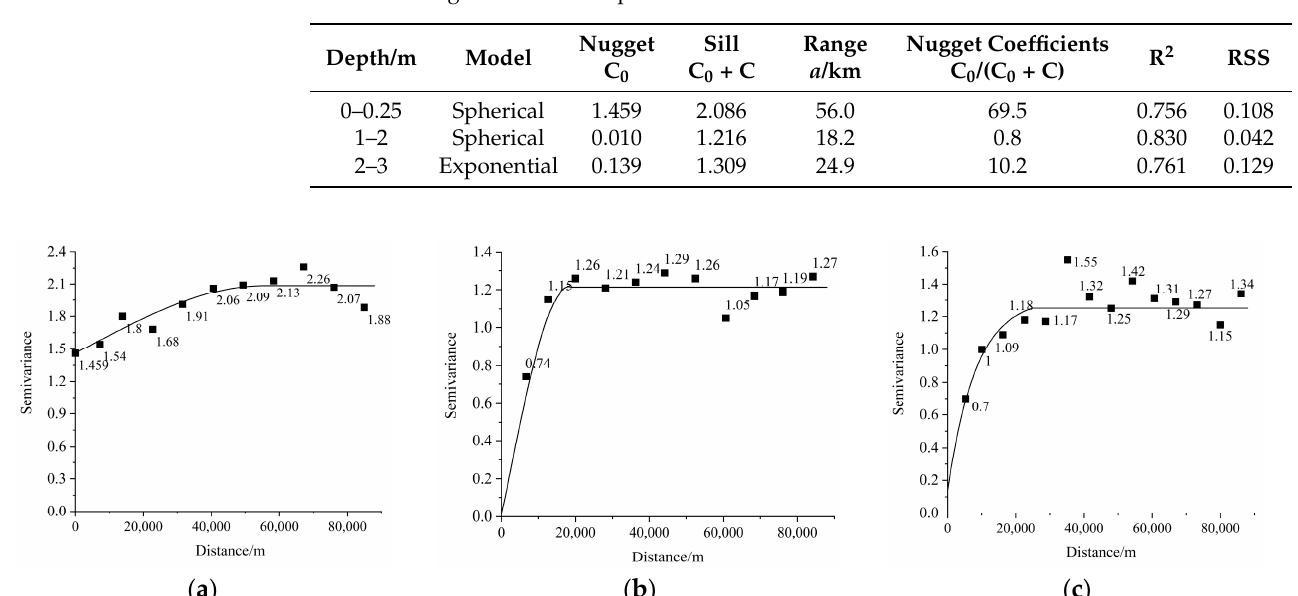
Figure 6. Semi variance function of soil salt content: variogram of soil salinity in the layers between 0 m and 0.25 m ( a ); variogram of soil salinity in the layers between 1 m and 2 m ( b ); variogram of soil salinity in the layers between 2 m and 3 m ( c ).